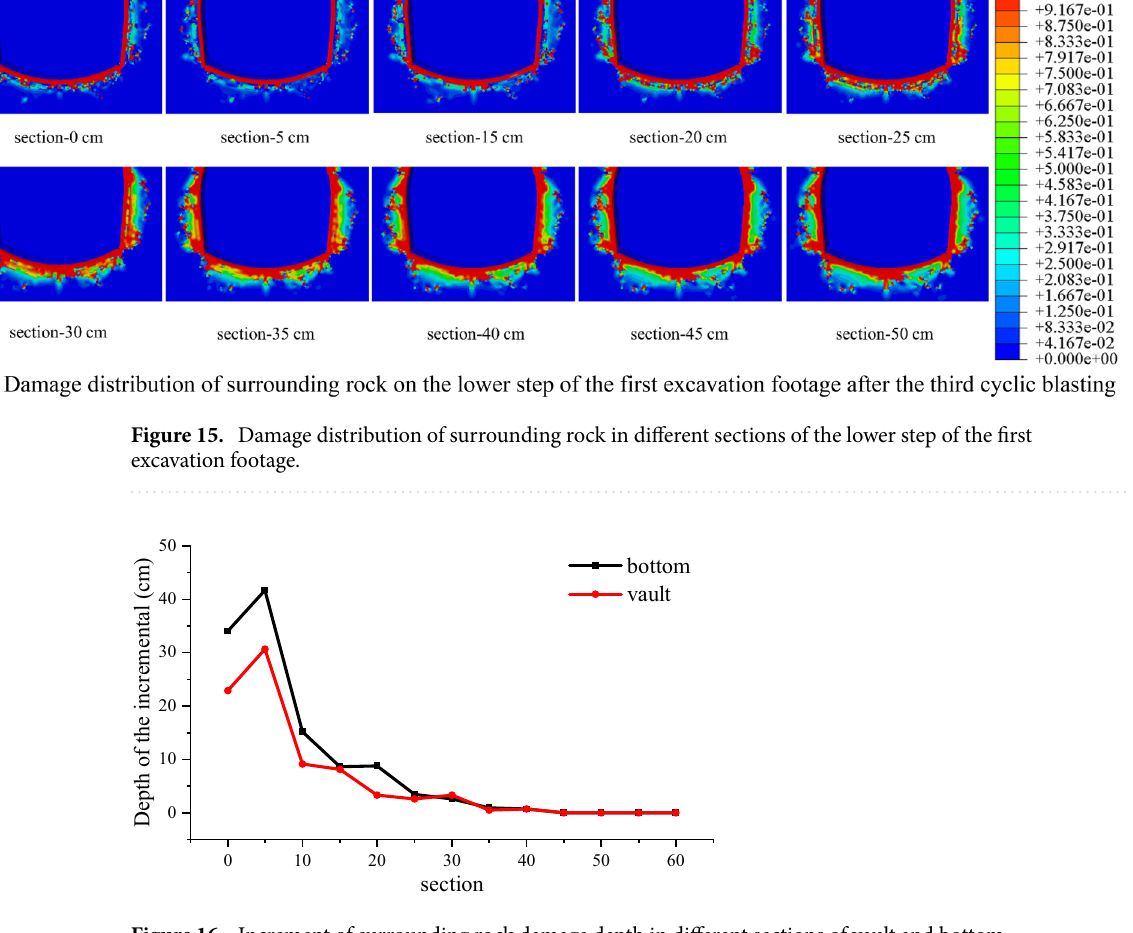
Figure 16. Increment of surrounding rock damage depth in different sections of vault and